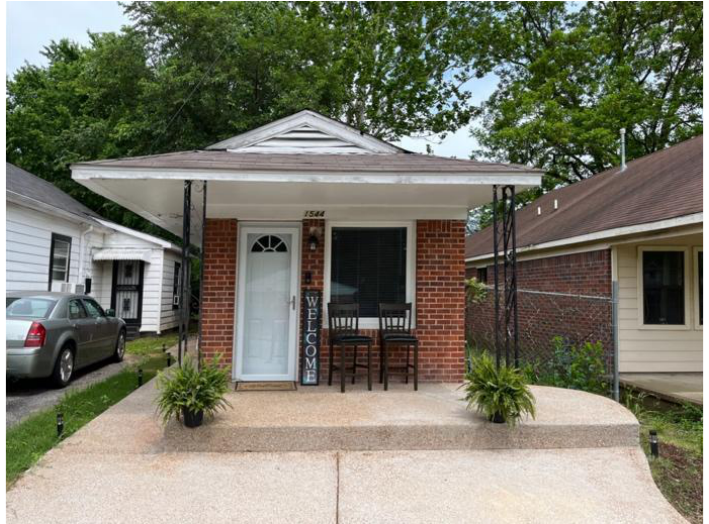
Figure 1. Exterior view of an MSH tiny home. The front porch lacks any form of defensive architecture, amplified by the “welcome” sign and the two chairs by the front door.